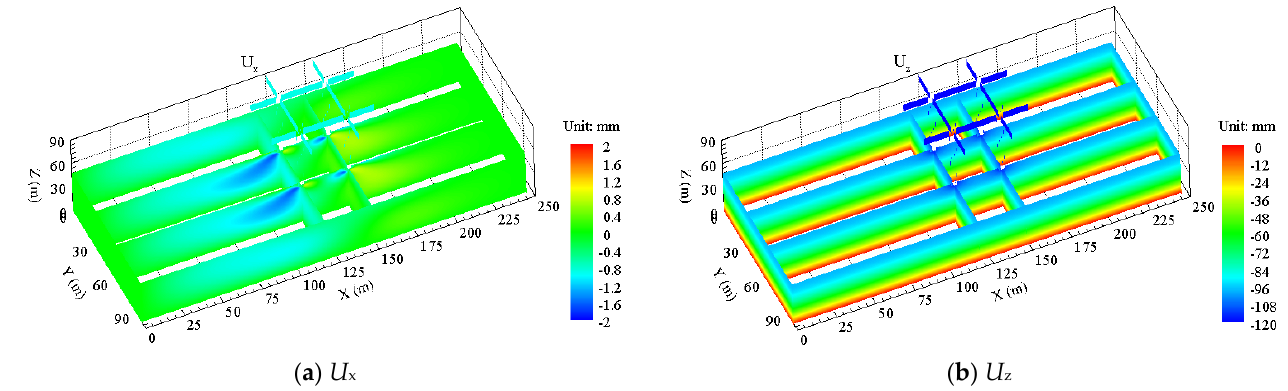
Figure 12. Displacement distribution in the x and z directions in the initial state.